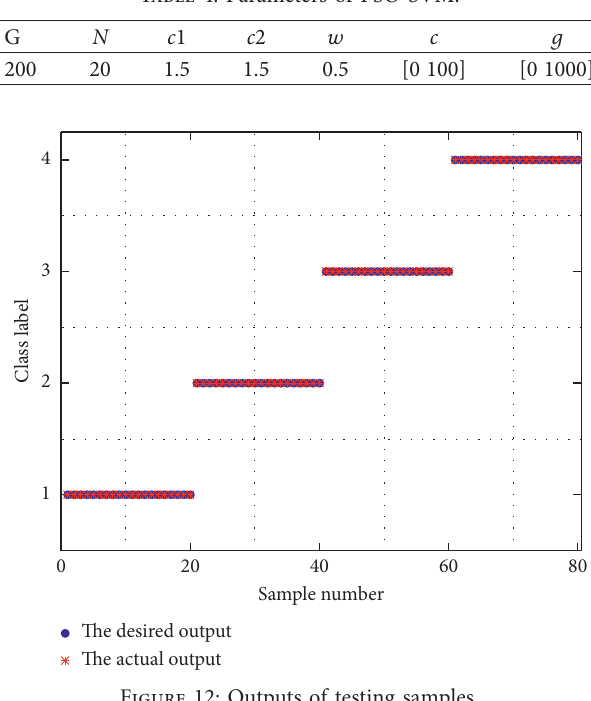
Table 4: Parameters of PSO-SVM.